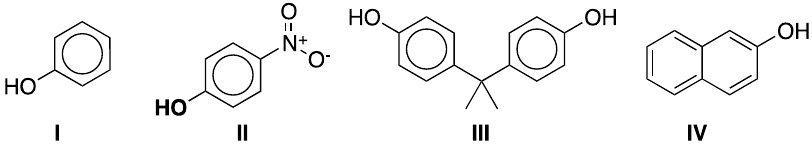
Figure 3. Model phenolic compounds phenol ( I ) and 4-nitrophenol ( II ) and representative phenolic pollutants bisphenol-A ( III ) and β -naphthol ( IV